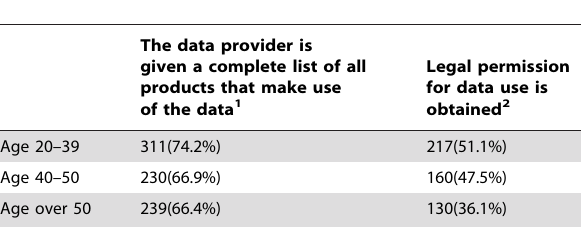
Table 26. Others using data by age